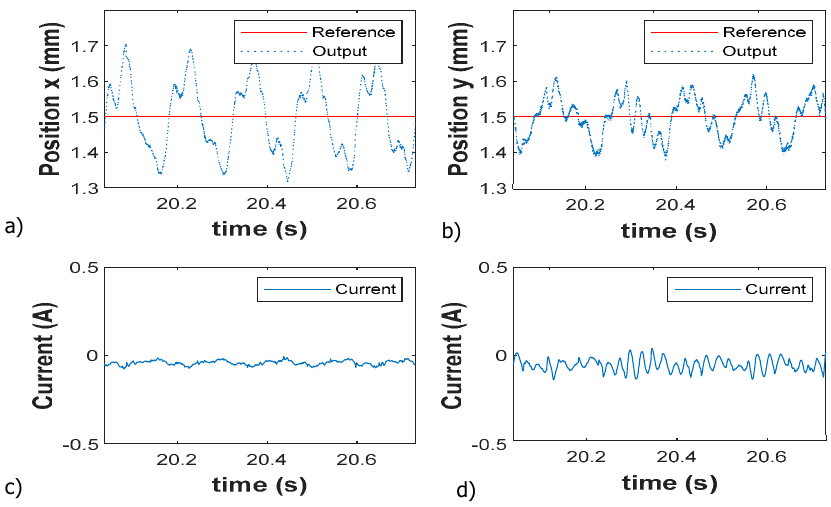
Figure 15. The response of control current when 2-DOF AMB is spun at 500 rpm.